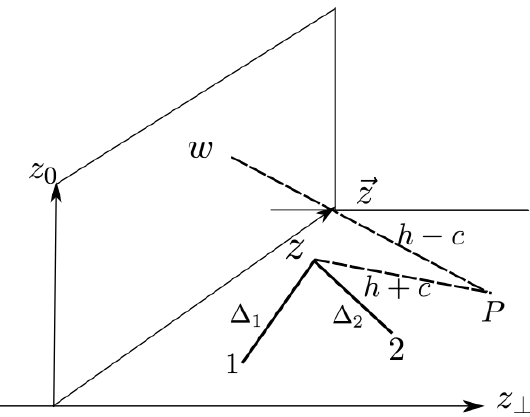
Figure 5 . Using the split representation of the bulk-to-bulk propagator the bulk exchange Witten diagram is reduced to the product of a three-point contact Witten diagram and an one-point contact Witten